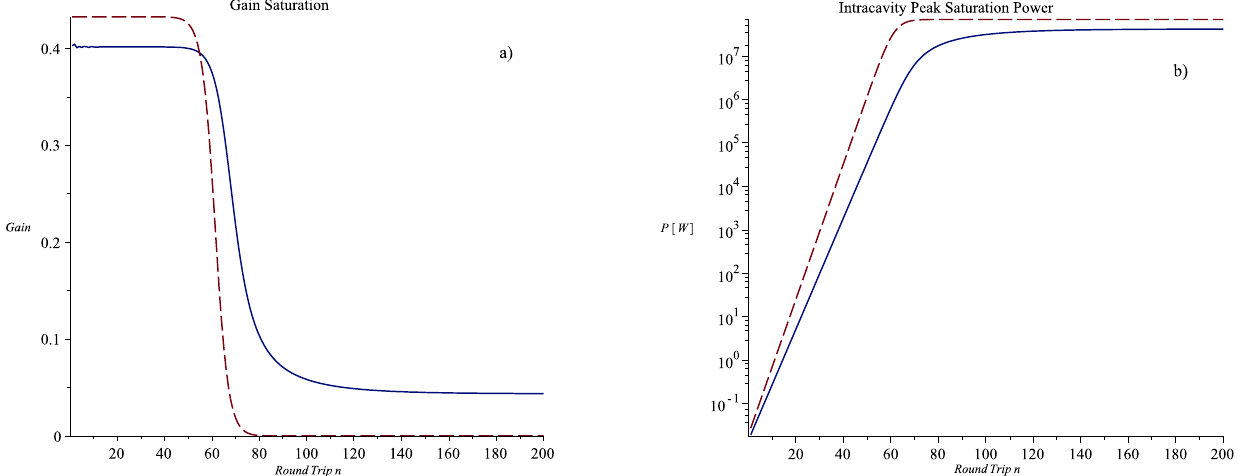
Figure 3. Saturation behaviour: ( a ) gain as a function of the round-trip number; and ( b ) intracavity power as a function of the round-trip number.